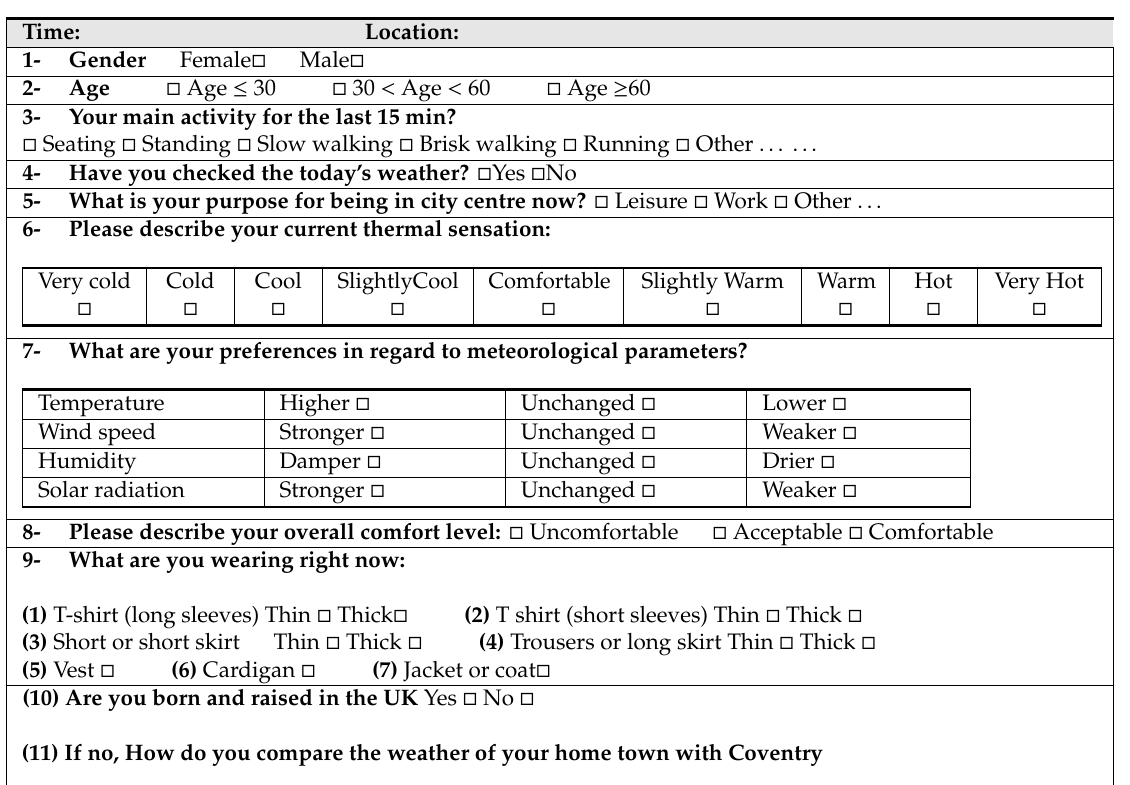
Table A1. Outdoor thermal comfort questionnaire. The aim of this survey is to evaluate thermal conditions of the public spaces in Coventry City Centre. We appreciate your feedback in this evaluation. Please tick the square box where